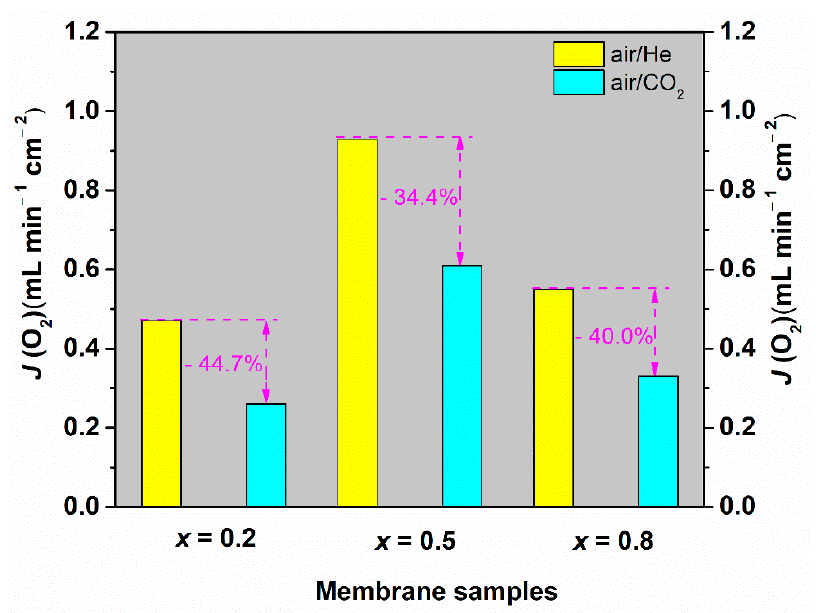
Figure 8. Oxygen permeation fluxes through the Ce 0.9 Pr 0.1 O 2 − δ –Nd x Sr 1 − x Fe 0.9 Cu 0.1 O 3 − δ ( x = 0.2, 0.5, 0.8) membranes (thickness: 0.6 mm) under air/He and air/CO 2 gradients at 1223 K.